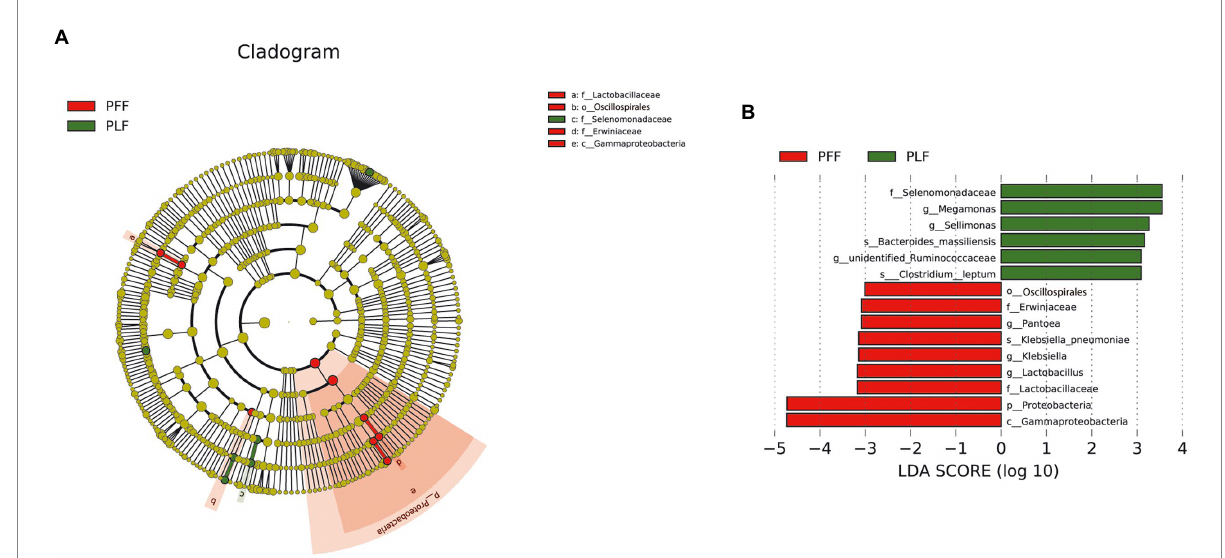
FIGURE 1 The identified biomarkers of gut microbiota composition by LEfSe analysis. (A,B) The LEfSe plot is presented with a threshold LDA score of 3.0. There were nine identified biomarkers (six identified genera) that differed between the PFF and PLF groups. PFF, pregnant women at 30–32 weeks of gestation. PLF, pregnant women at full